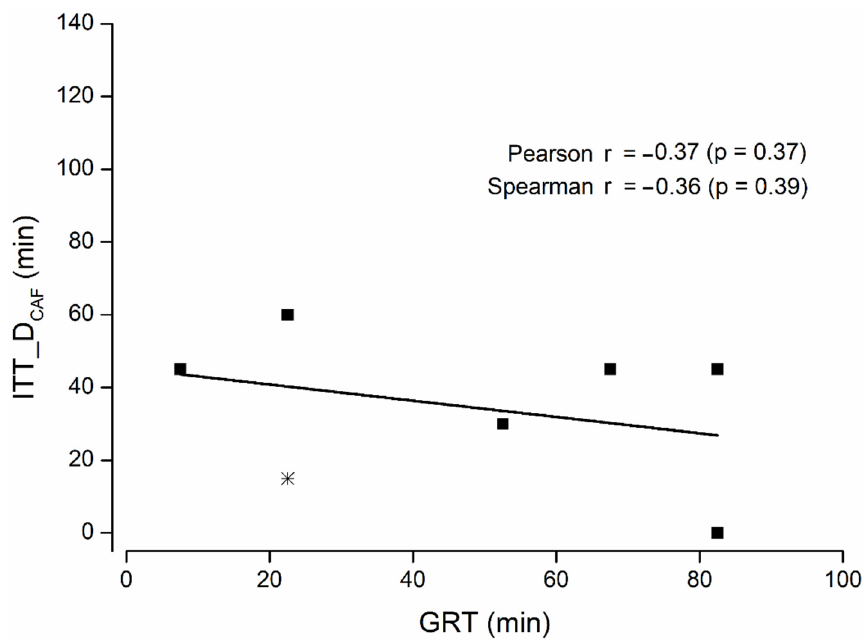
Figure 3. ITT_D by caffeine appearance related to GRT (n = 8). Capsule disintegration in the colon is highlighted as a star (*). Correlation is marked by a bar; correlation coefficients and corresponding values are stated.